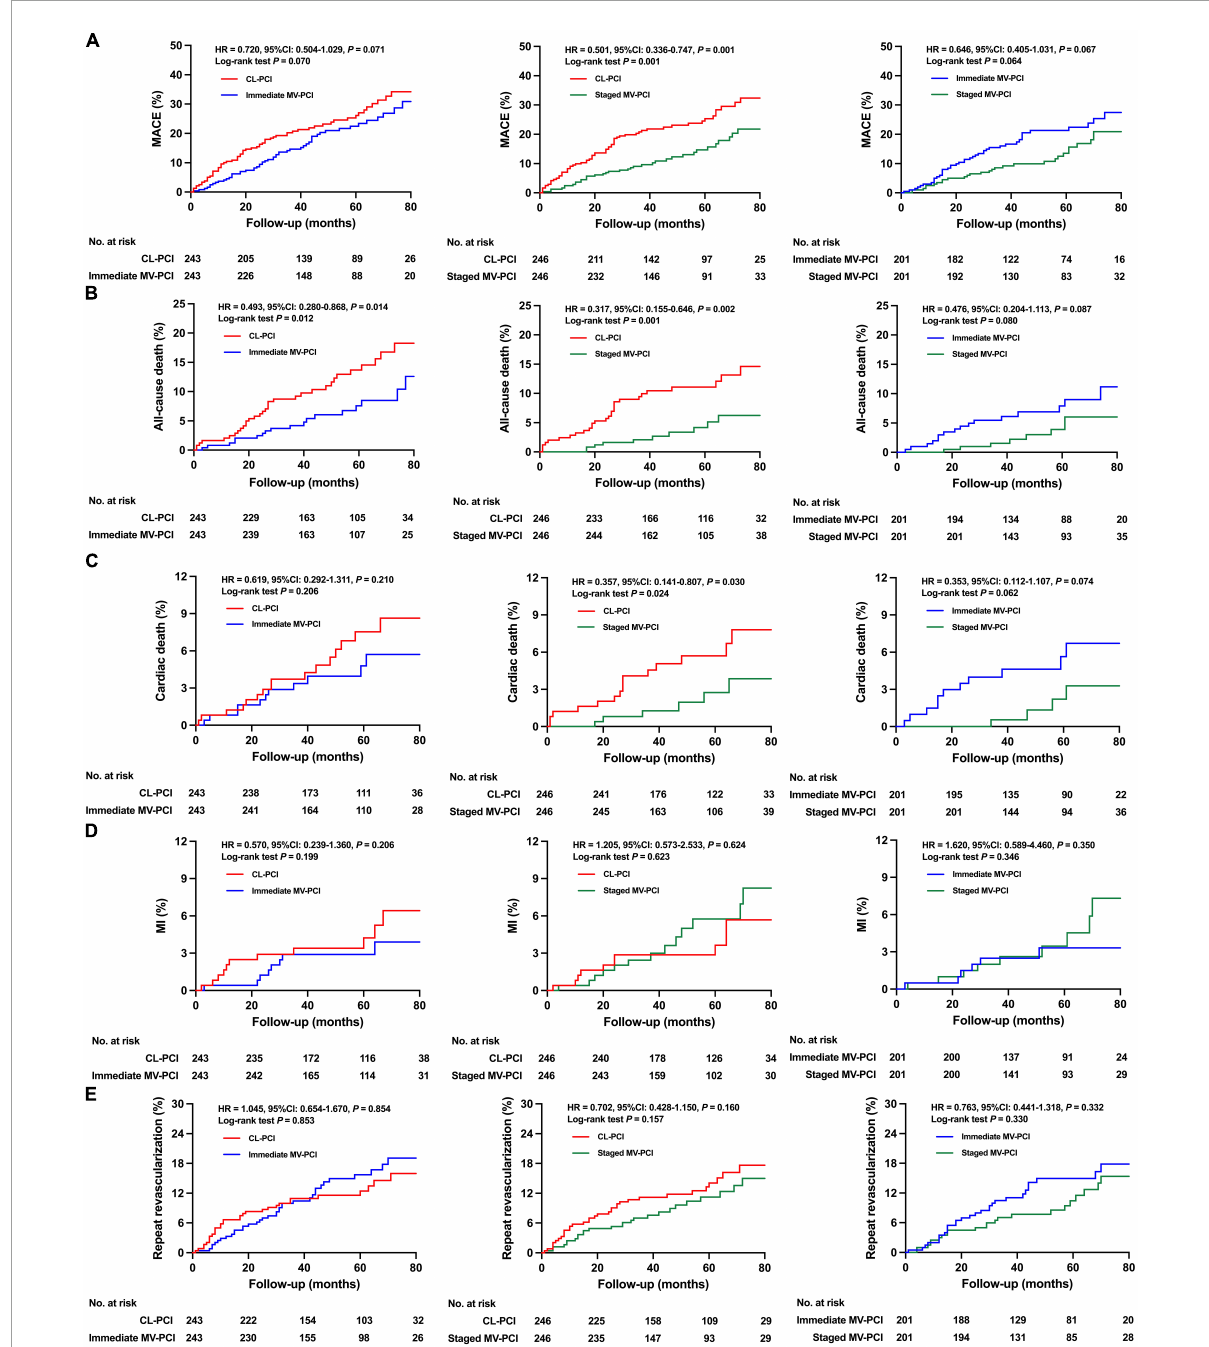
FIGURE3 Clinical outcomes for propensity score matched patients. Cumulative incidence of (A) MACE, (B) all-cause death, (C) cardiac death, (D) MI, and (E) repeat revascularization. MACE, major adverse cardiac events; MI, myocardial infarction; CL-PCI, culprit-only percutaneous coronary intervention; MV-PCI, multivessel percutaneous coronary